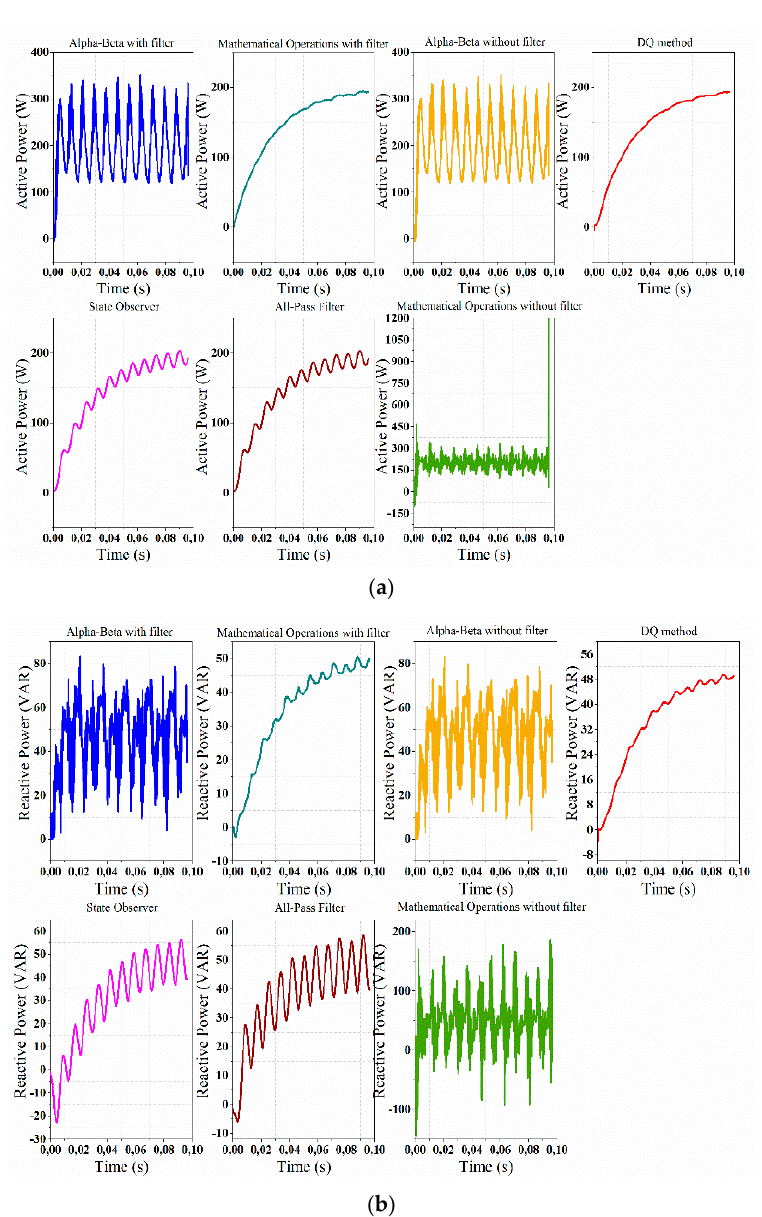
Figure 10. Power time responses: ( a ) active power; ( b ) reactive power (down).